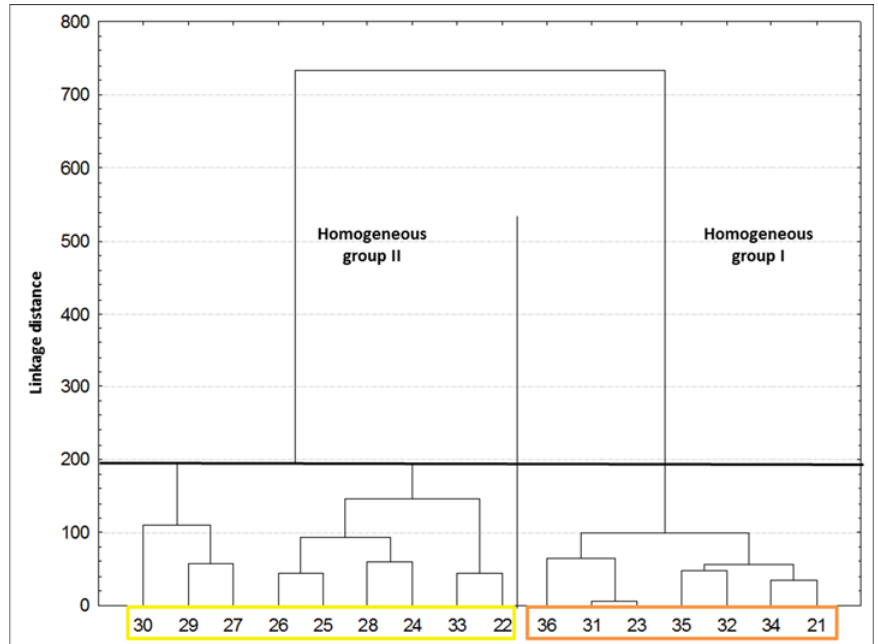
Figure 3. Dendogram with pluviometric stations and meteorological stations and their homogeneous pluviometric groups for the Litorânea watershed.